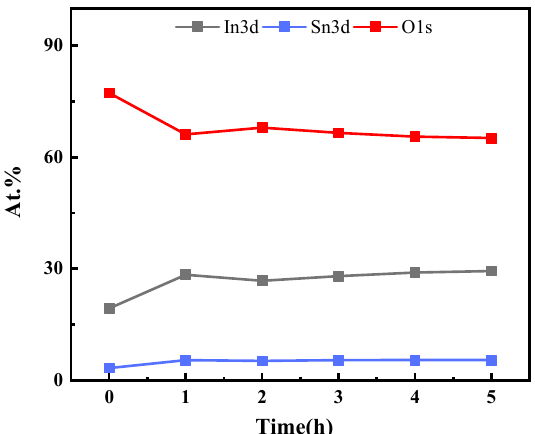
Figure 5. XPS results of ITO films fabricated for different annealing times.